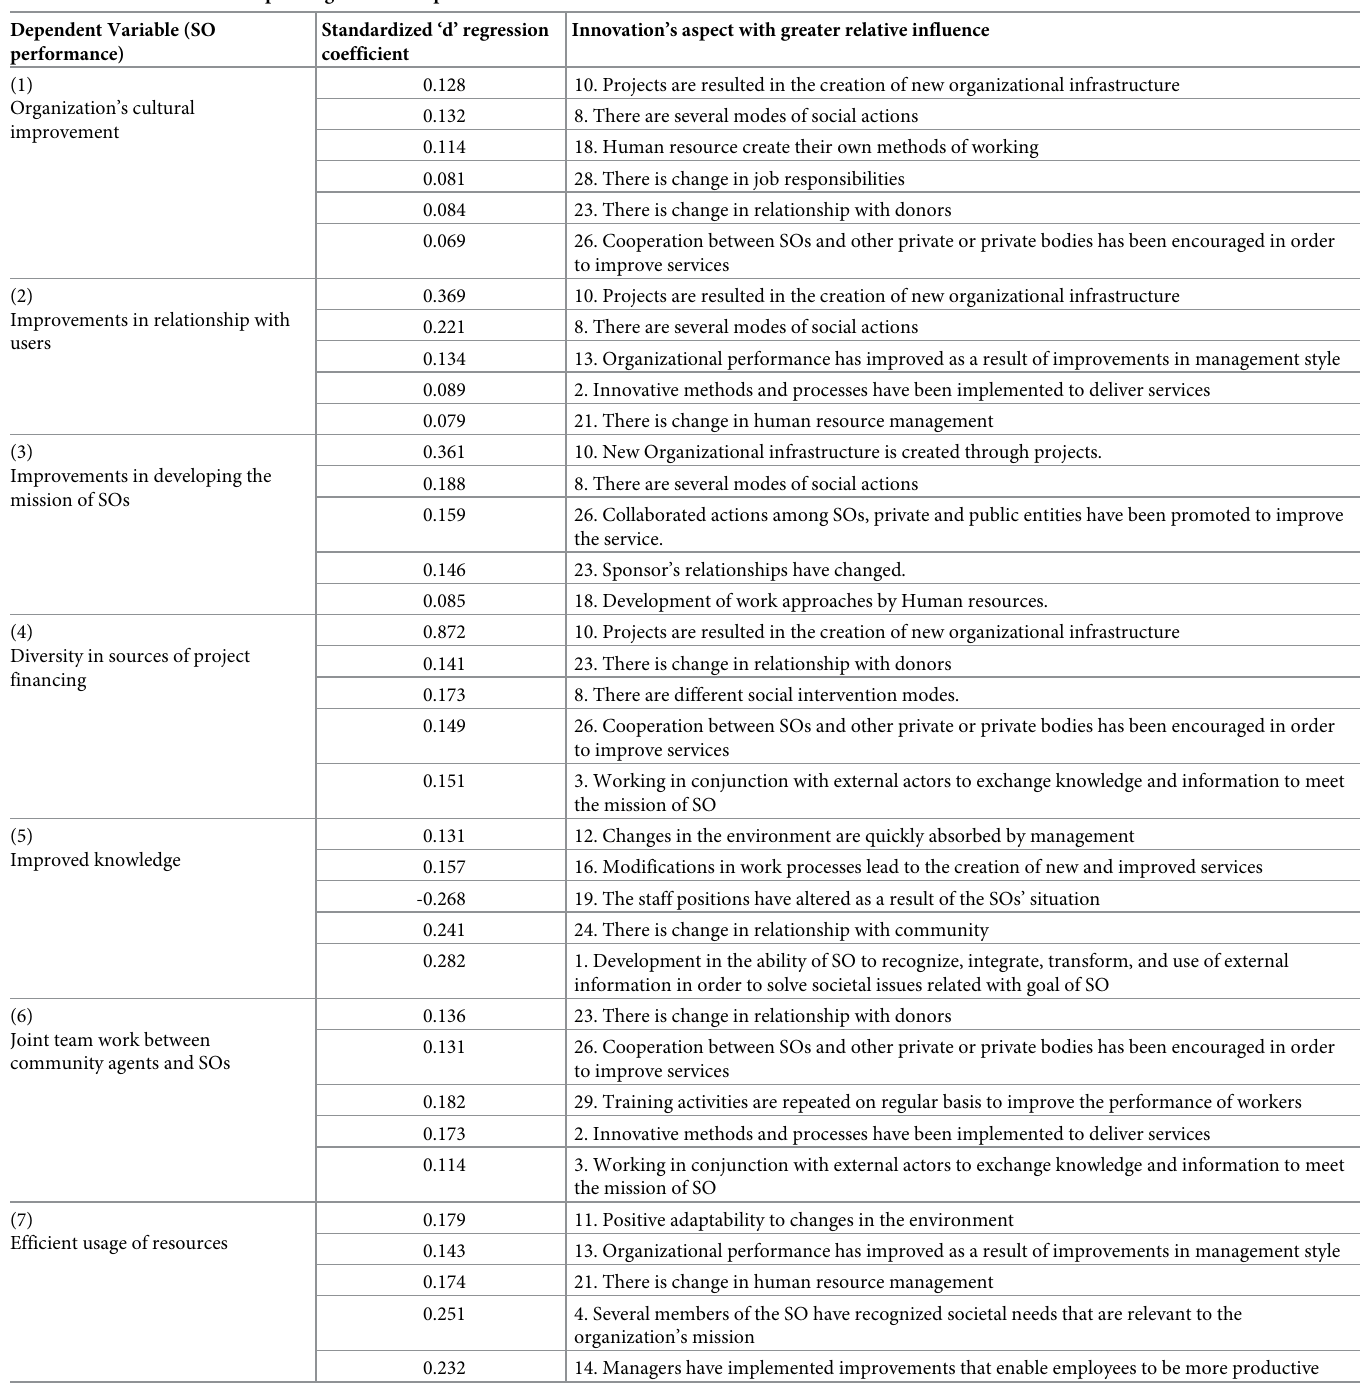
Table 5. OI and SI activities explaining the main aspects of OP. Dependent Variable (SO